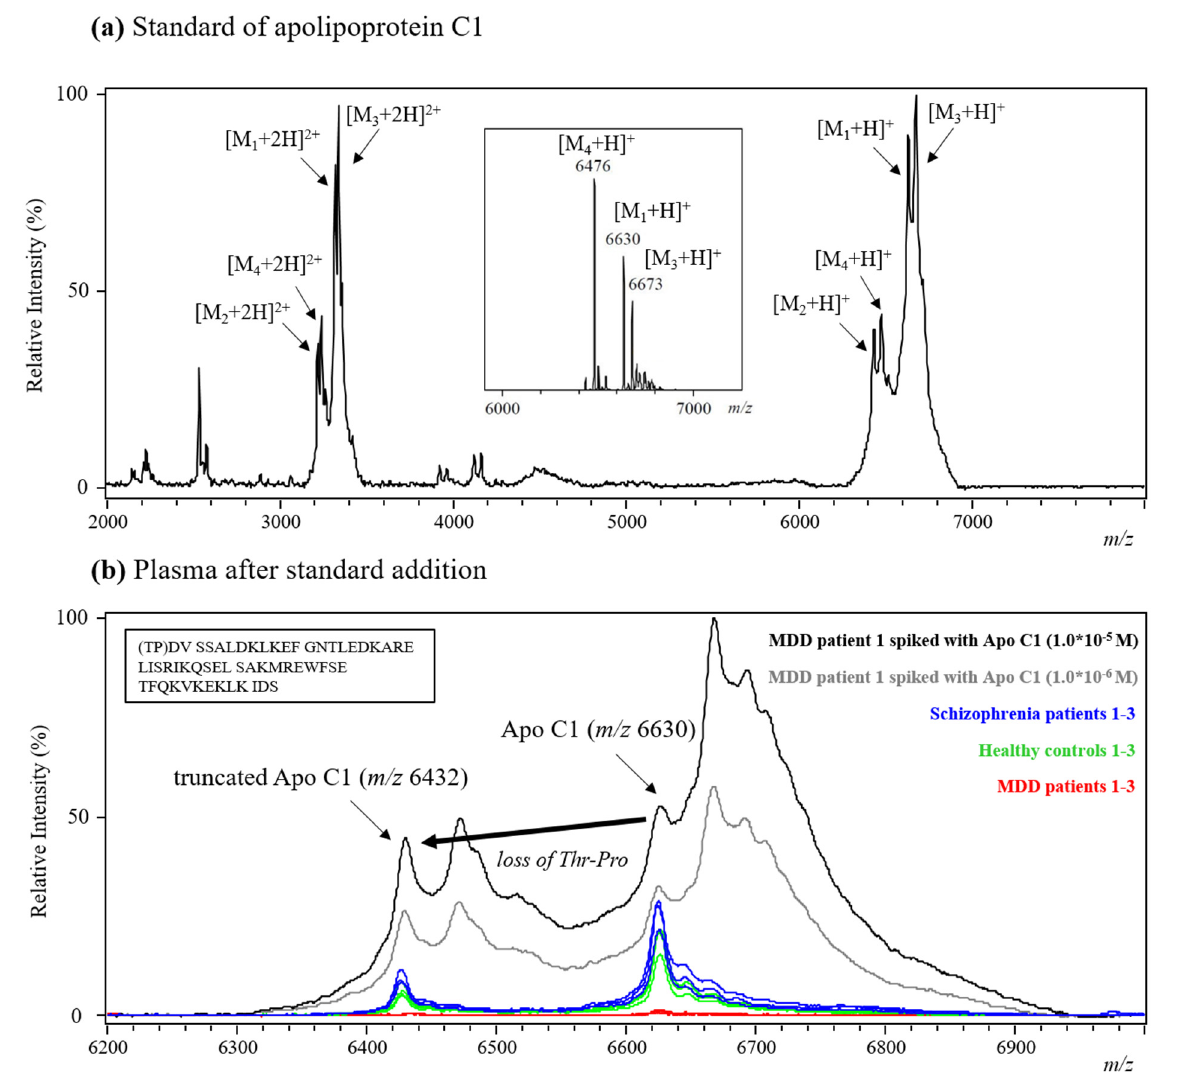
Figure 8. ( a ) The positive MALDI spectrum of the Apo C1 standard (inset: deconvoluted ESI-QTOF mass spectrum of Apo C1 standard). ( b ) MALDI mass spectra recorded from the analysis of TFA-hydrolyzed plasma collected from three schizophrenia patients, three healthy controls, three MDD patients, and one MDD patient’s spiked with the Apo C1 standard (inset: amino acids sequence of Apo C1).